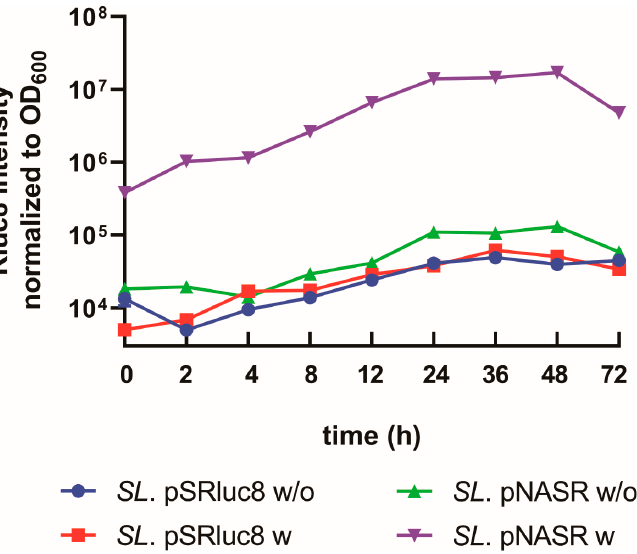
Figure 4. Switch inheritance and permanency. SL . pSRluc8 and SL . pNASR were incubated overnight without ( w / o ) or with ( w , 100 µ M) DETA/NO, and diluted 1:100 in fresh LB media without DETA/NO. Rluc8 intensity was measured at the indicated time points after removal of DETA/NO, and was normalized to the number of bacterial cells (OD 600 ). Each point represents the mean ± SEM of triplicate determinations.